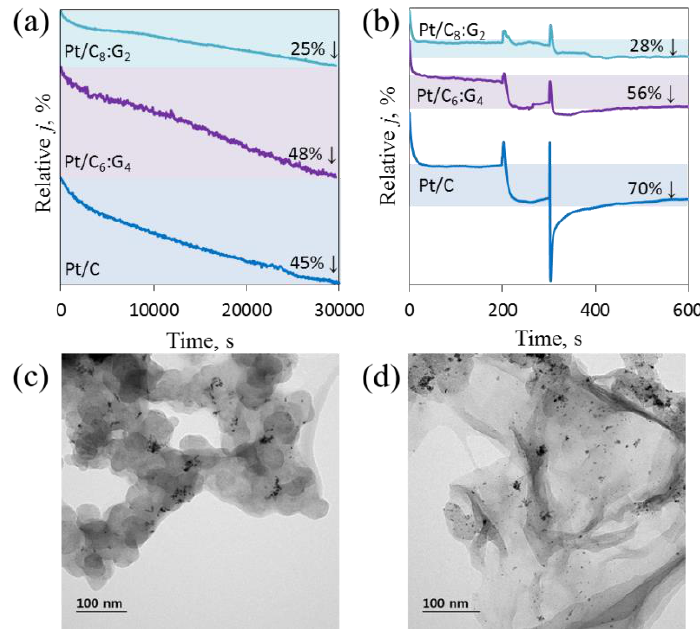
Figure 6. The chronoamperometry (CA) responses for ORR at the Pt/C and Pt/C 8 :G 2 electrodes for long term stability test ( a ) and selectivity test ( b ) with the addition of 2 M ethanol and methanol, respectively, in an O 2 -saturated 0.1 M HClO 4 solution at 1600 rpm rotation speed and at an applied potential of 0.8 V (versus RHE); a comparison of TEM images of Pt/C ( c ), and Pt/C 8 :G 2 ( d ) after long-term stability